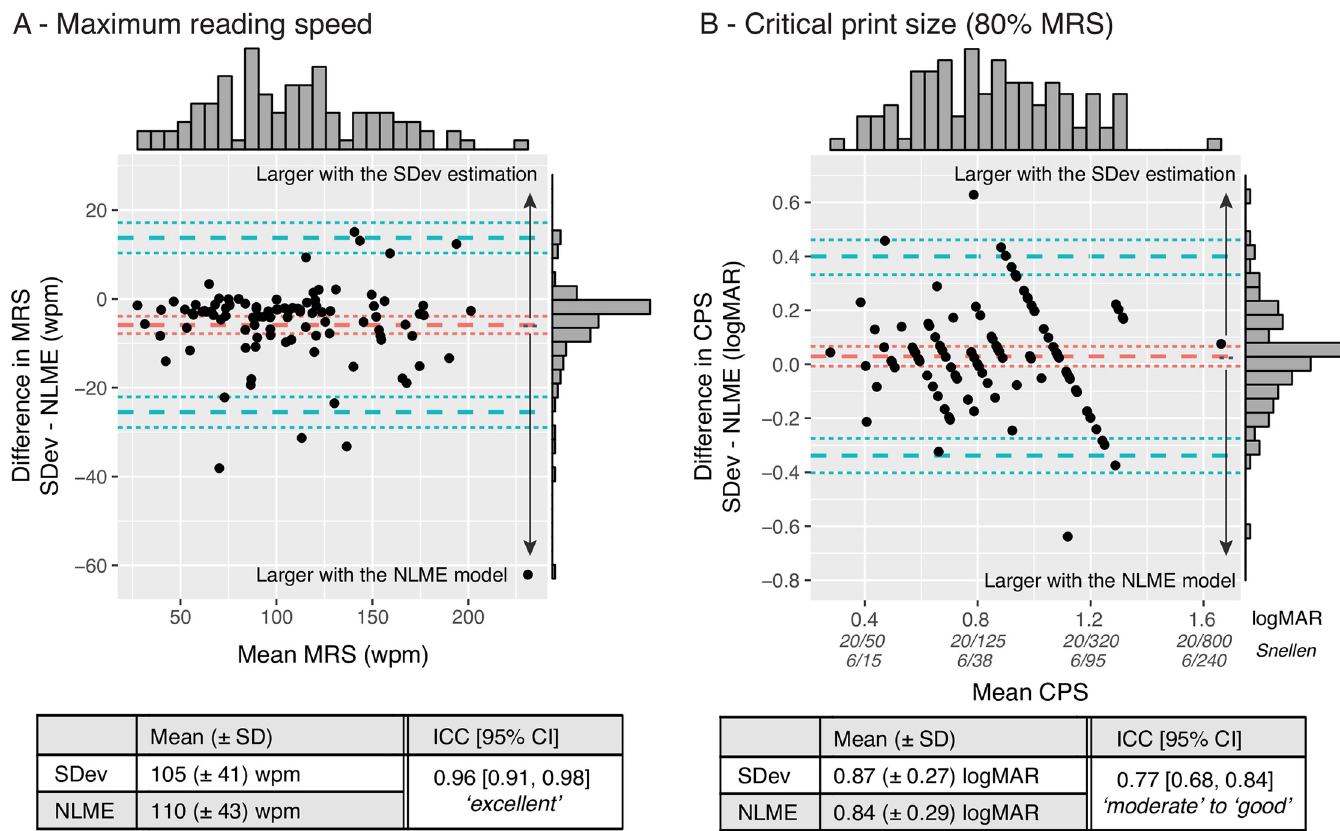
Fig 4. Bland–Altman plots showing agreement between SDev and NLME methods for both MRS (left) and CPS (right). x-axes represent the mean estimate for both methods; y-axes represent the estimate difference between the two methods (SDev—NLME). In both subplots, the red dashed lines represent the mean difference (i.e. bias) and the blue dashed lines represent the agreement limits ( ± 1.96 SD). The dotted lines show the 95%CI of the limits; top and right histograms show the data distribution along the x- and y-axes respectively. Tables summarize the SDev and NLME average values as well as their ICC values of absolute agreement.